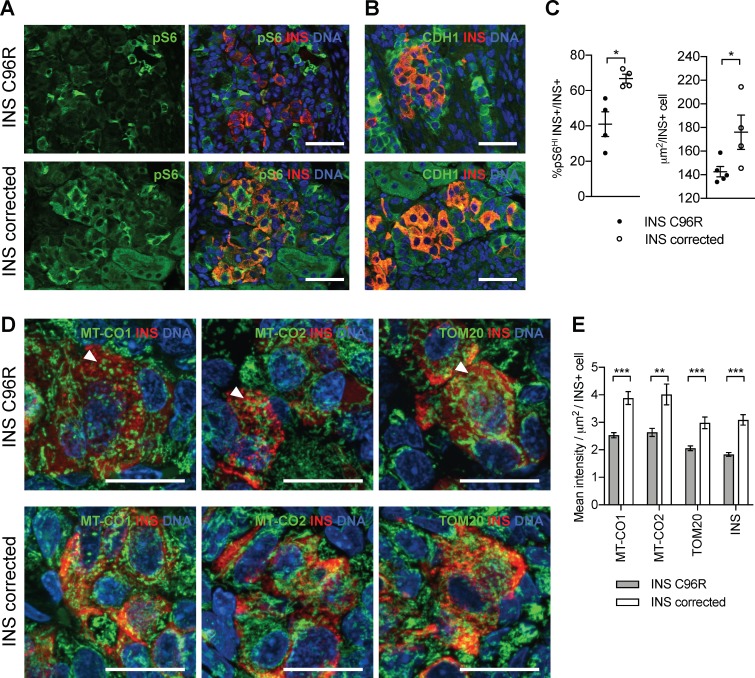
Transplanted INS mutant beta-like cells presented reduced mTORC1 signaling, reduced size and decreased mitochondrial respiratory chain subunits expression.(A) Immunohistochemistry for the mTORC1 activity marker pS6 and INS in 3 months old grafts. (B) Immunohistochemistry for E-Cadherin (CDH1) and INS to quantify beta-cell size. Scale bars in (A) and (B) = 50 μm. (C) Quantification of (A) and (B) (n = 4–5 independent transplanted animals per genotype; Student’s t test). (D) Immunohistochemistry for mitochondrial proteins cytochrome oxidase subunit 1 (MT-CO1) and 2 (MT-CO2), transporter of the outer membrane 20 (TOM20) and INS in 3 months old grafts. Quantification of the mean fluorescence intensity of each immunostaining per individual INS+ cell (n > 100 individual INS+ cells per genotype, from 4 to 5 independent transplanted animals per genotype; Student’s t test). Scale bars = 20 μm. **p < 0.01, ***p < 0.001.